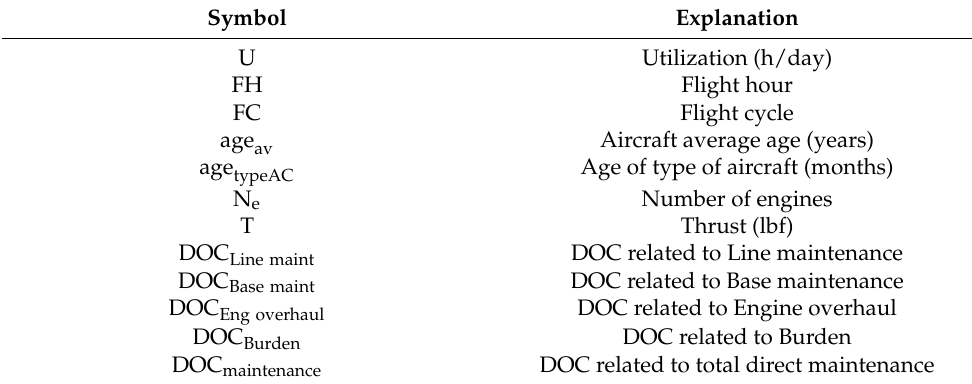
Table 11. Maintenance cost symbols explanation.